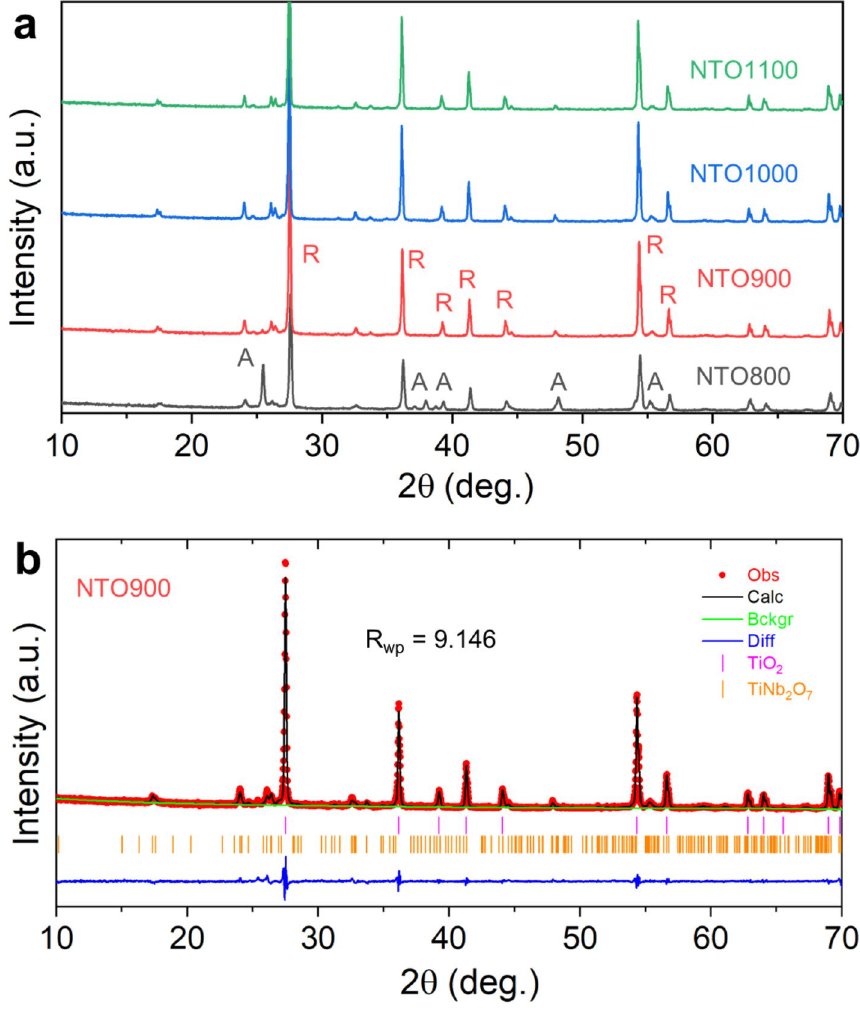
Figure 3. ( a ) X-ray diffraction patterns of Nb-TiO 2 calcined at various temperatures (800, 900, 1000, and 1100 °C). A and R labels correspond go anatase and rutile phases, respectively. ( b ) Rietveld-refined X-ray diffraction pattern of NTO900 with a yielded goodness-of-fit factor of